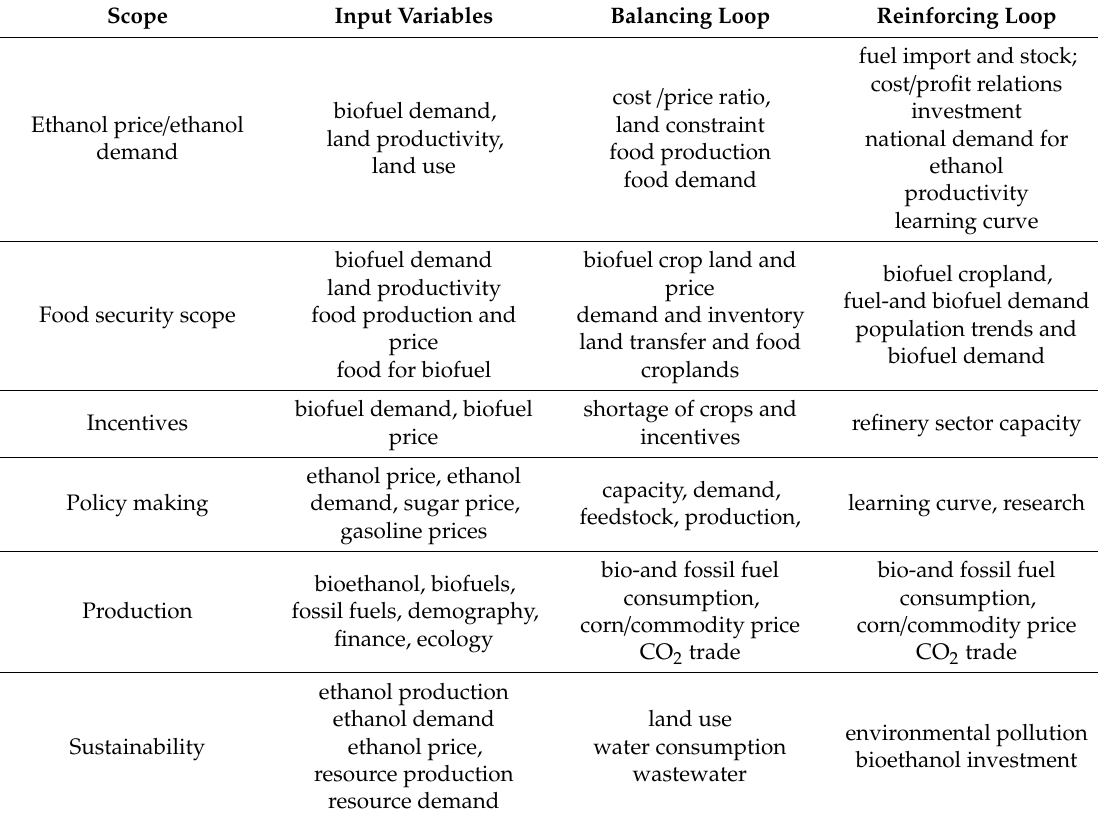
Table 4. The most important characteristic features of